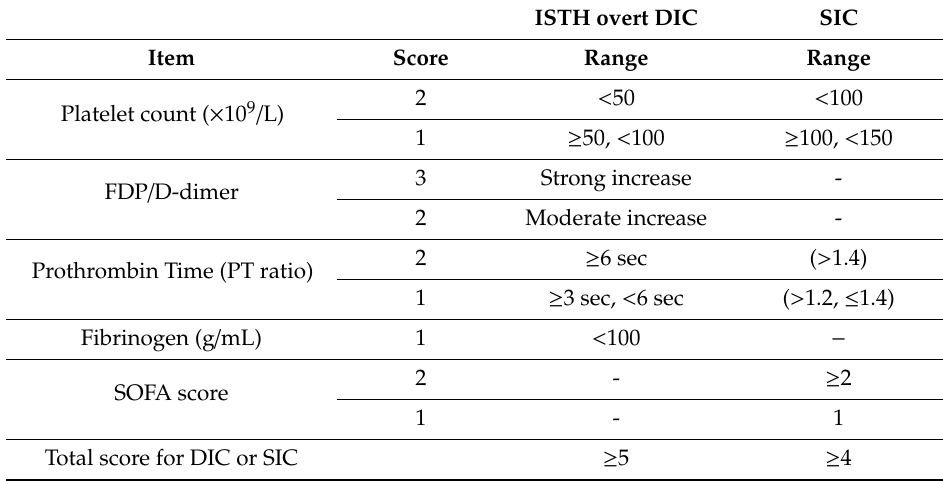
Table 1. ISTH overt DICand SIC scoring